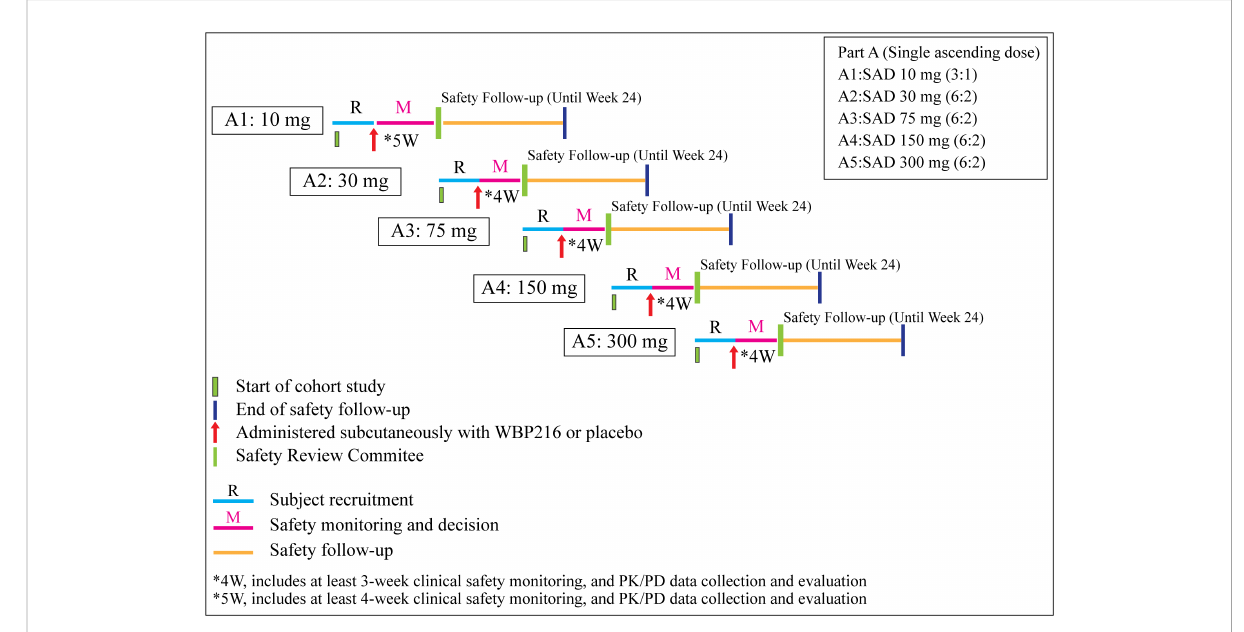
FIGURE 1 Schematic presentation of the study. W, week; SAD, single ascending dose; PK, pharmacokinetic; PD,